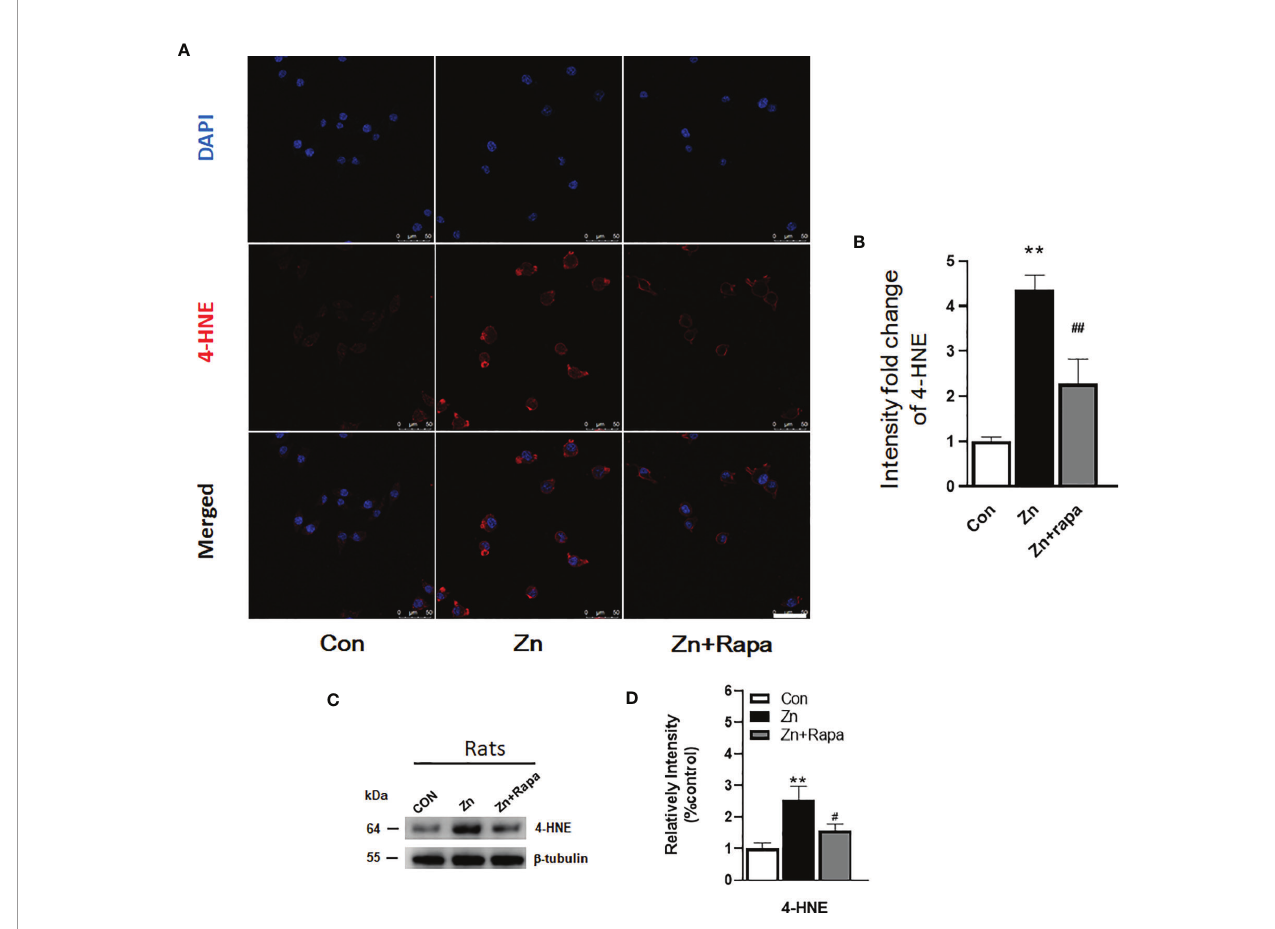
FIGURE 4 | Rapamycin attenuated the zinc-induced increase in the expression of 4-hydroxynonenal (4-HNE) both in vitro and in vivo . (A, B) Representative confocal images and quanti fi cation of the fl uorescence intensity for immuno fl uorescence staining using anti-4-HNE antibody (red) in SH-SY5Y cells in the control, zinc, and zinc +rapamycin groups, scale bar = 50 m m. Nuclei were counterstained with DAPI (blue). All confocal images are presented as the fold change relative to control cells. (C, D) Representative blots and quanti fi cation of the expression levels of 4-HNE in rats in the control, zinc, and zinc+rapamycin groups. n = 4 rats per group in the same membrane. **p < 0.01 vs. control group; #p < 0.05, ##p < 0.01 vs. rapamycin treatment. Quanti fi cations of the blots were normalized to b